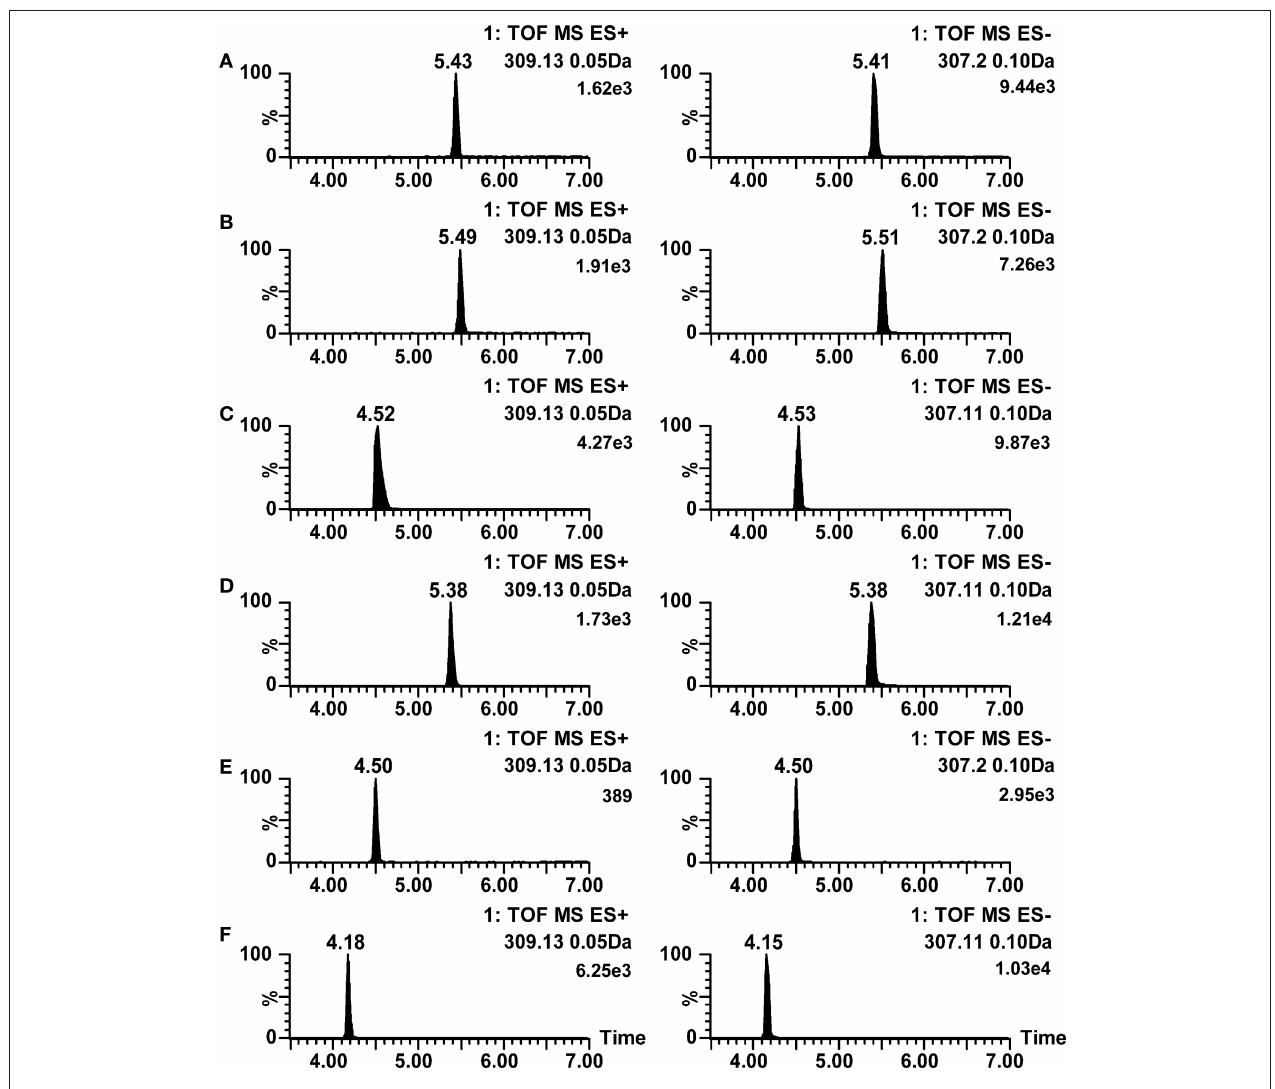
FIgurE 2 | Positive and negative ion mode LC–ESI–TOF–MS ion chromatograms for warfarin at various mobile phase pH conditions. (A) 0.1% formic acid (pH 2.8); (B) 0.1% acetic acid (pH 3.2); (C) 2